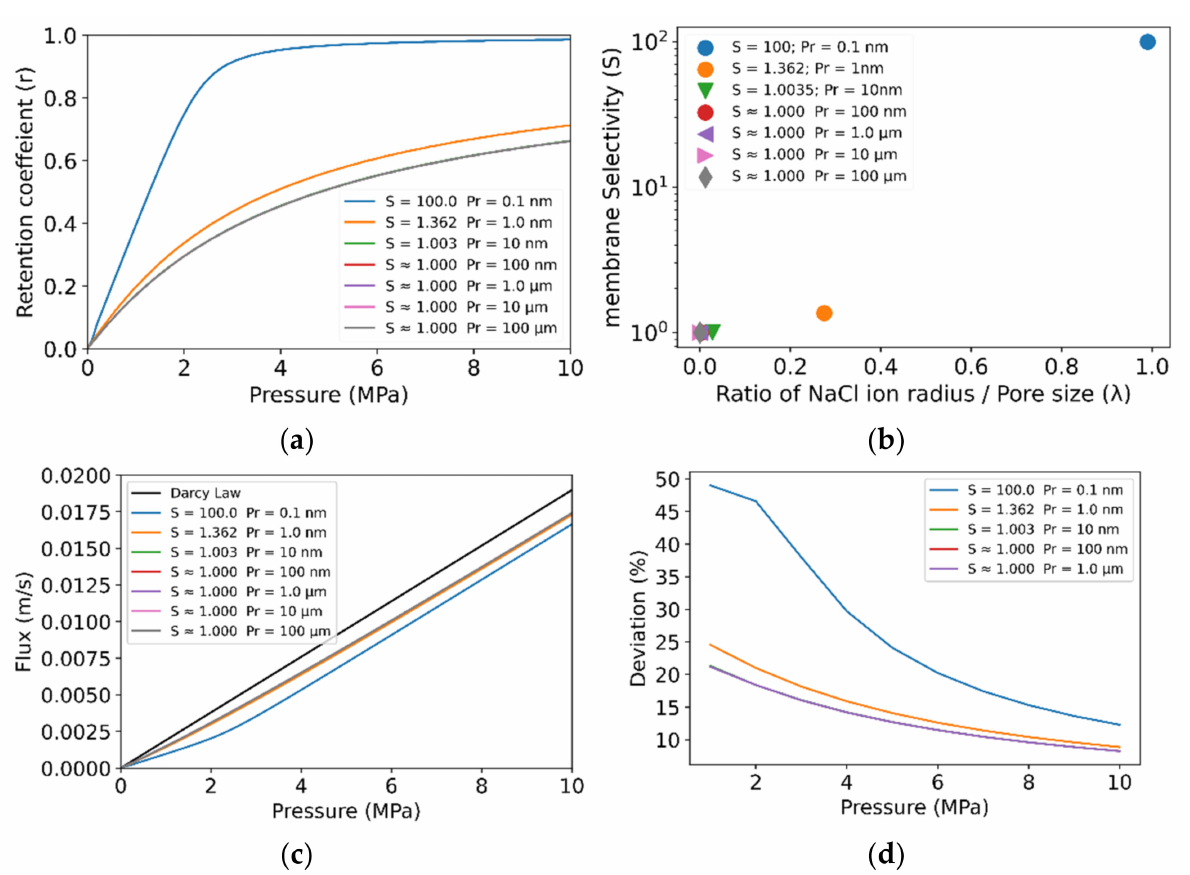
Figure 5. Effect of reverse osmosis on the resultant flow velocity at pore radii. S is the selectivity coefficient and Pr is the pore radius of zone B. ( a ) The membrane retention coefficient at different pore radii. ( b ) The ratio of solute to pore radius against selectivity of ultra-low permeability zone; ( c ) Darcy law with and without reverse osmosis. ( d ) Percentage deviation of simulated results from the Darcy